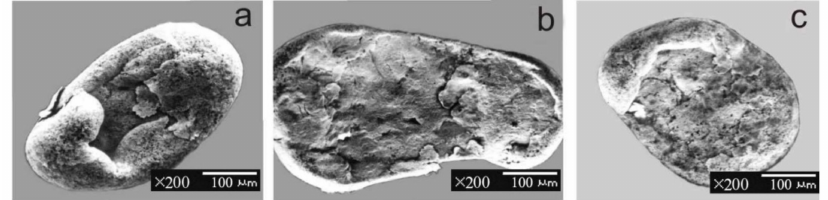
Figure 5. The different nature of the transformation of gold particles, depending on their shape in the course of the experiment: ( a ) canoe-shaped; ( b ) ellipsoid-shaped, lamellar gold particle with ridgelike edges; ( c ) tabular gold particle with a